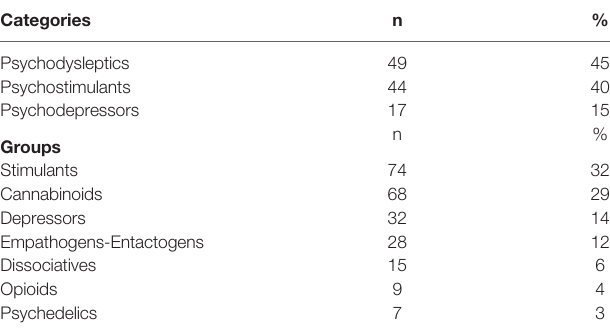
TABLE 2 | Categories and groups of abused substances.